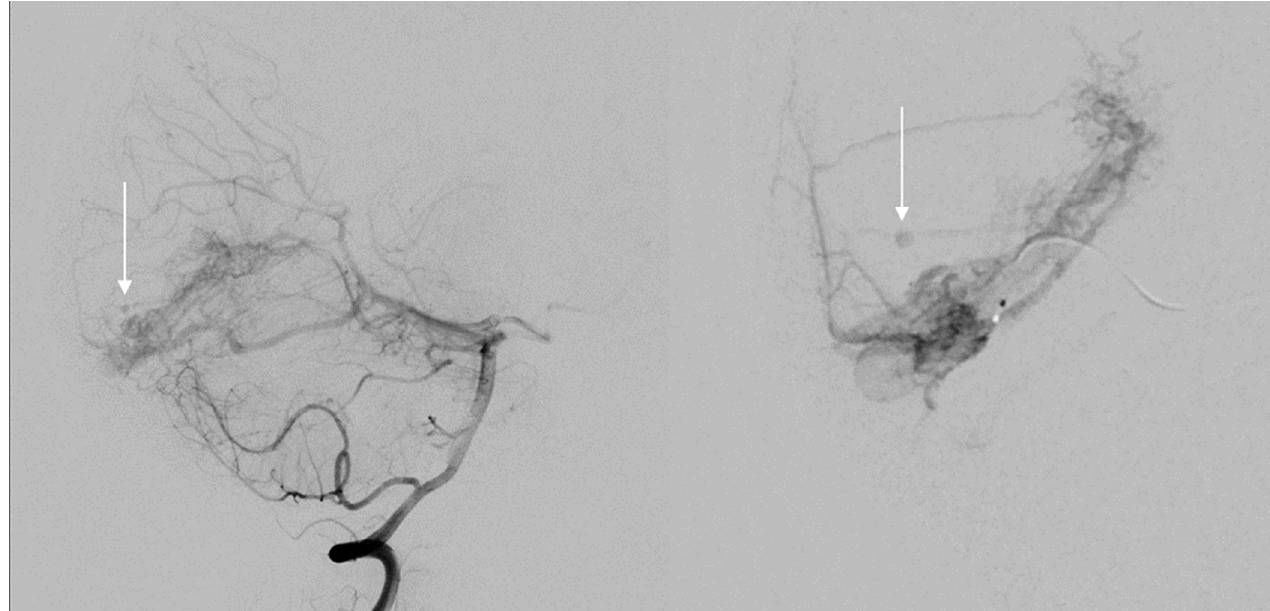
Figure 1. Spetzler–Martin (SM) grade III left occipital arteriovenous malformation (AVM) with supply from the left posterior cerebral artery (PCA) and superior cerebellar artery (SCA) and with an associated perinidal aneurysm (white arrow) that when ruptured is considered a higher risk for being the rupture point.